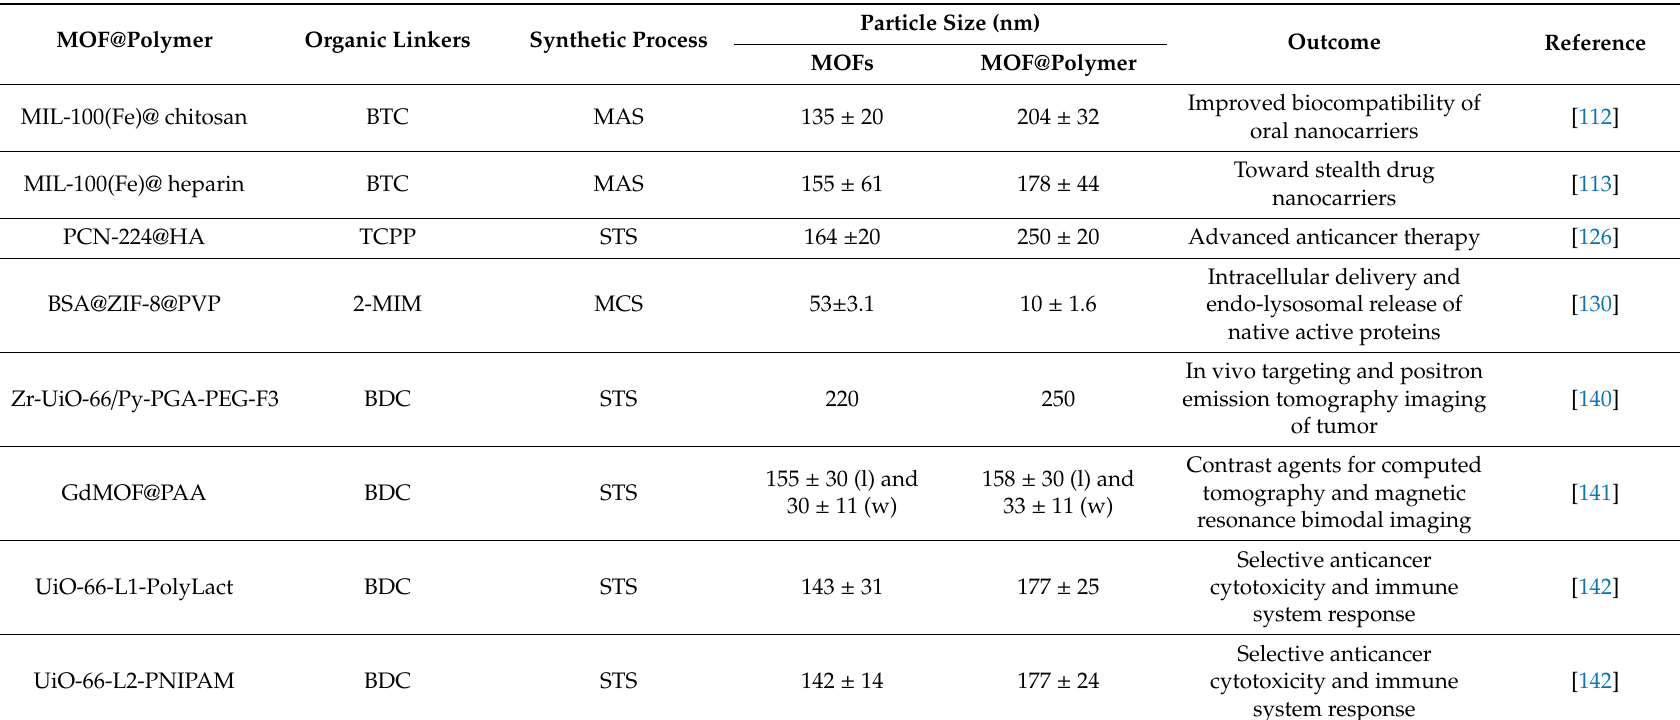
Table 1. Polymer-coated MOFs synthesized using various approaches for diverse advanced biomedical